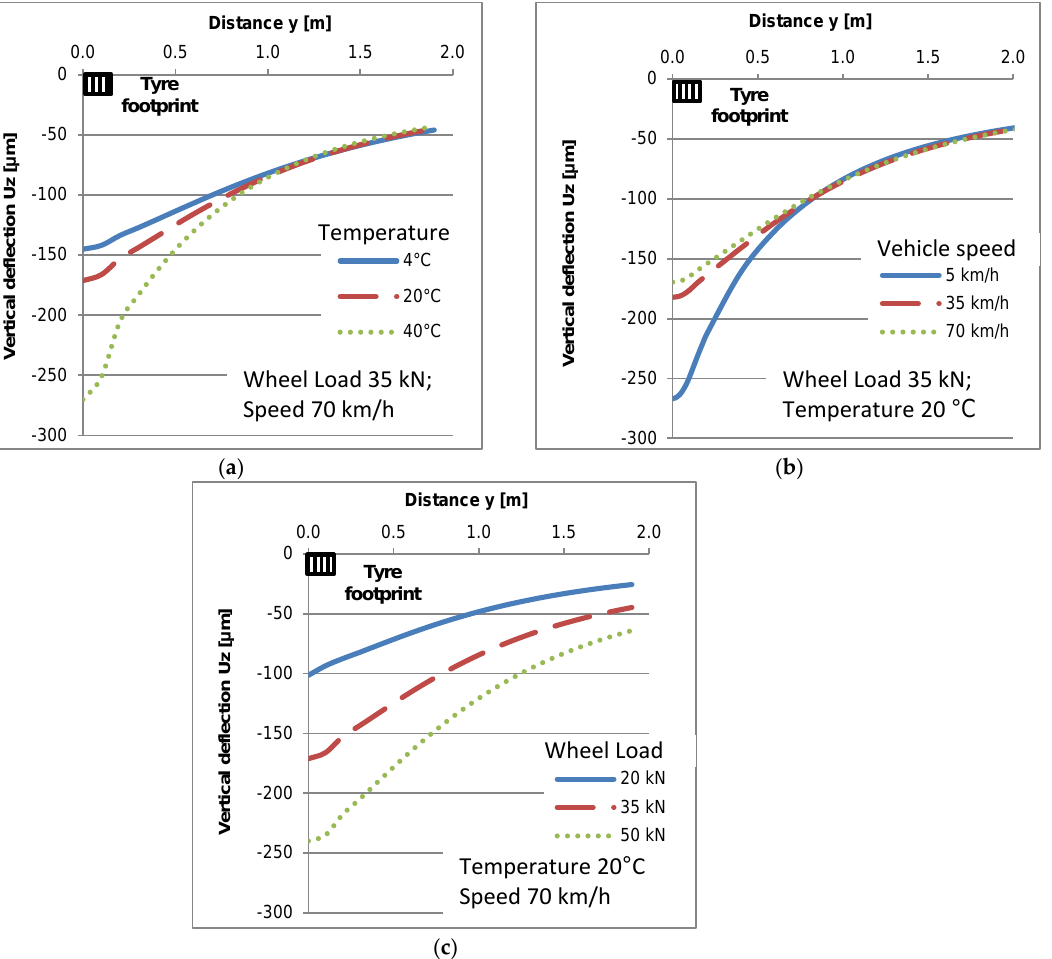
Figure 8. Pavement surface deflections under: ( a ) various temperatures and a constant wheel load and speed; ( b ) various speeds and a constant wheel load and temperature; ( c ) various wheel loads and a constant temperature and speed.